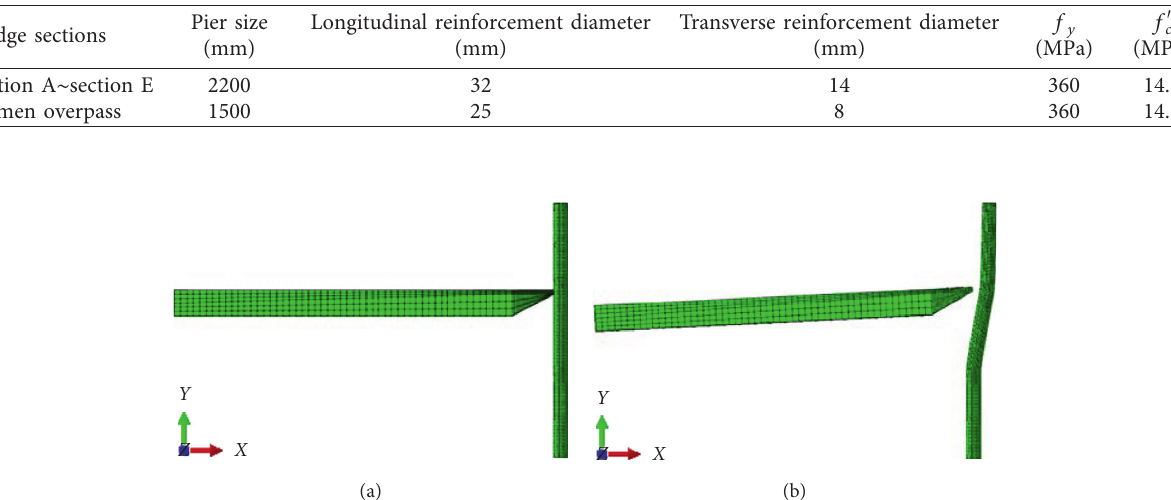
Table 5: Material properties of bridge piers.